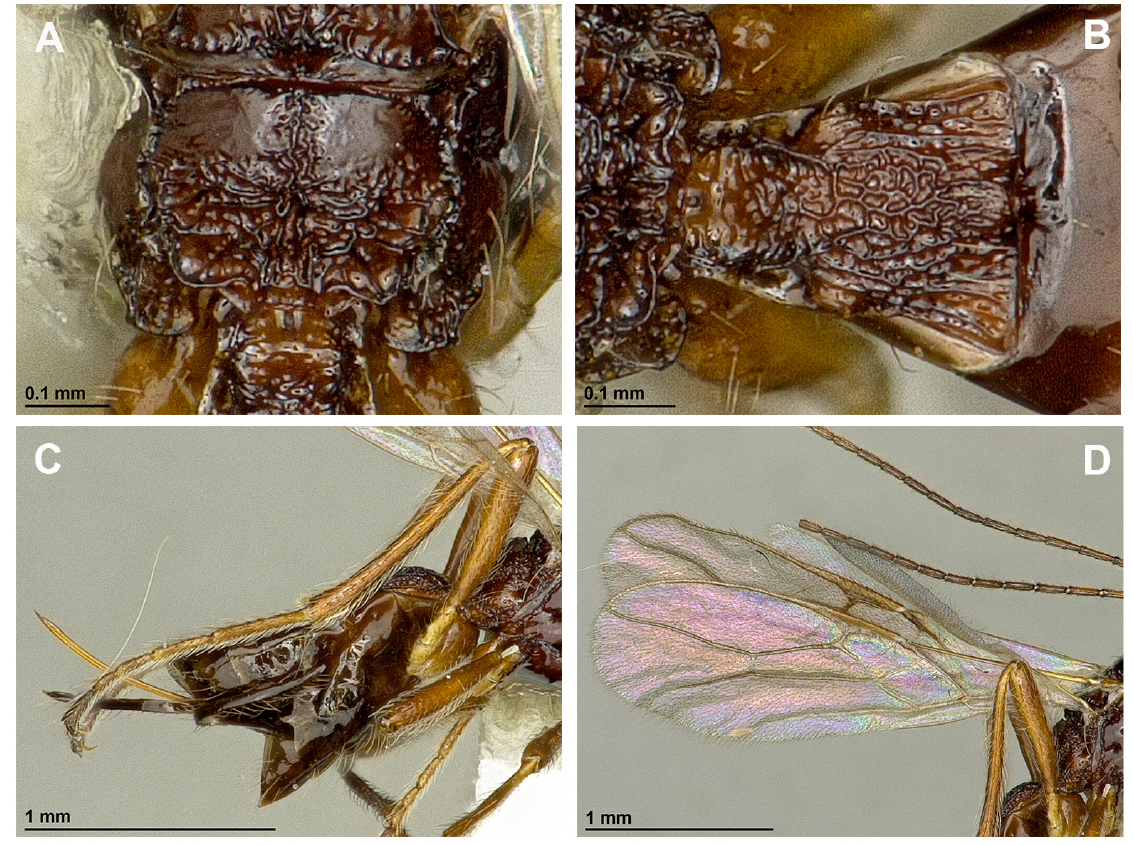
Fig. 75. Asobara victoriana Peris-Felipo, sp. nov., ♀, holotype (BMNH). A . Propodeum. B . First metasomal tergite, dorsal view. C . Hind leg, metasoma and ovipositor, lateral view. D . Fore